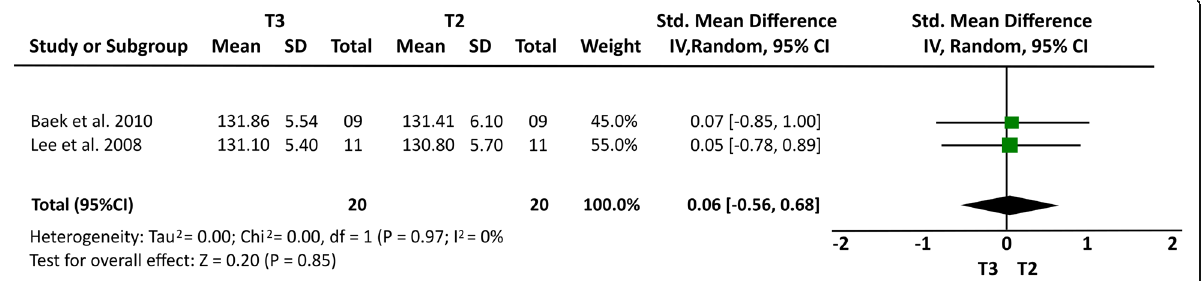
Fig. 7 Forest plot of L1-MP difference between T2 and T3 in patients who used TADs for molar intrusion after 1-year follow-up. 95% confidence interval and 95% prediction